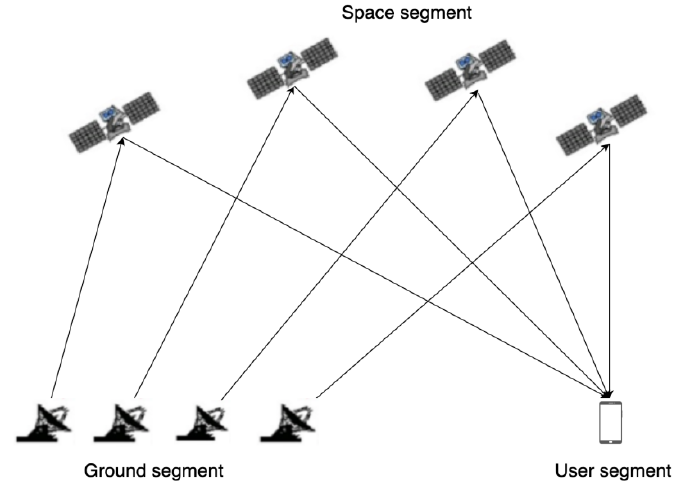
Figure 1. Schematic diagram of the principle of the CAPS system.